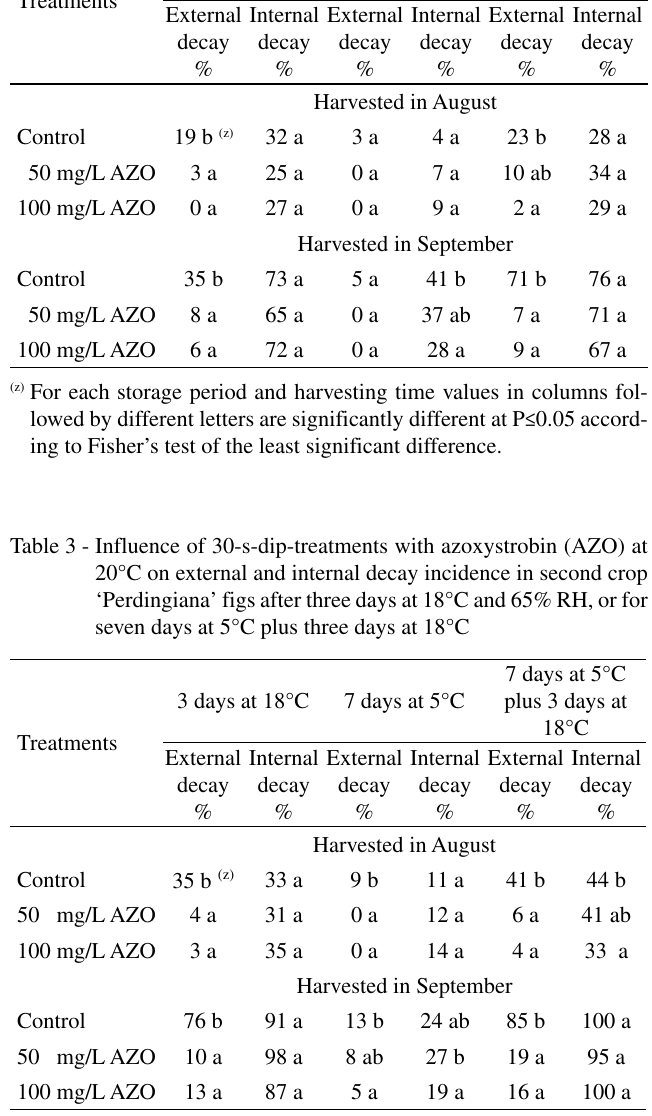
Table 2 - Influence of 30 s-dip treatments with azoxystrobin (AZO) at 20°C on external and internal decay incidence in second crop ‘San Pietro’ figs after three days at 18°C and 65% RH, or for seven days at 5°C plus three days at 18°C